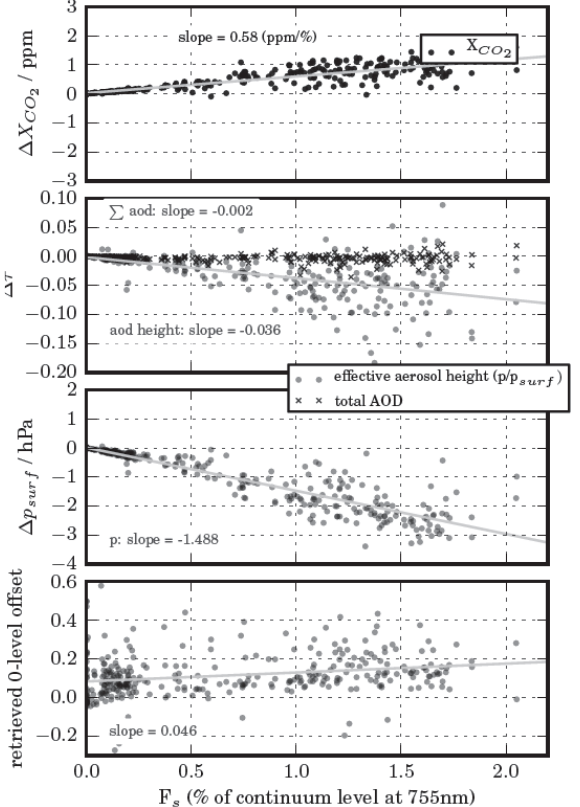
Fig. 10. Changes in retrieved X CO as well as aerosol induced by Fig. 9. Changes in retrieved X CO as well as aerosol induced by 2 2 chlorophyll fluorescence if it is fitted in the retrieval step in addi- chlorophyll fluorescence if it is ignored in the retrieval step but zero- tion to a zero-level offset fit (similar to the current ACOS retrievals) level offset fitted. Otherwise, identical to case #2a, Fig. 4. (O’Dell et al., 2011). Otherwise, identical to case #2b, Fig.